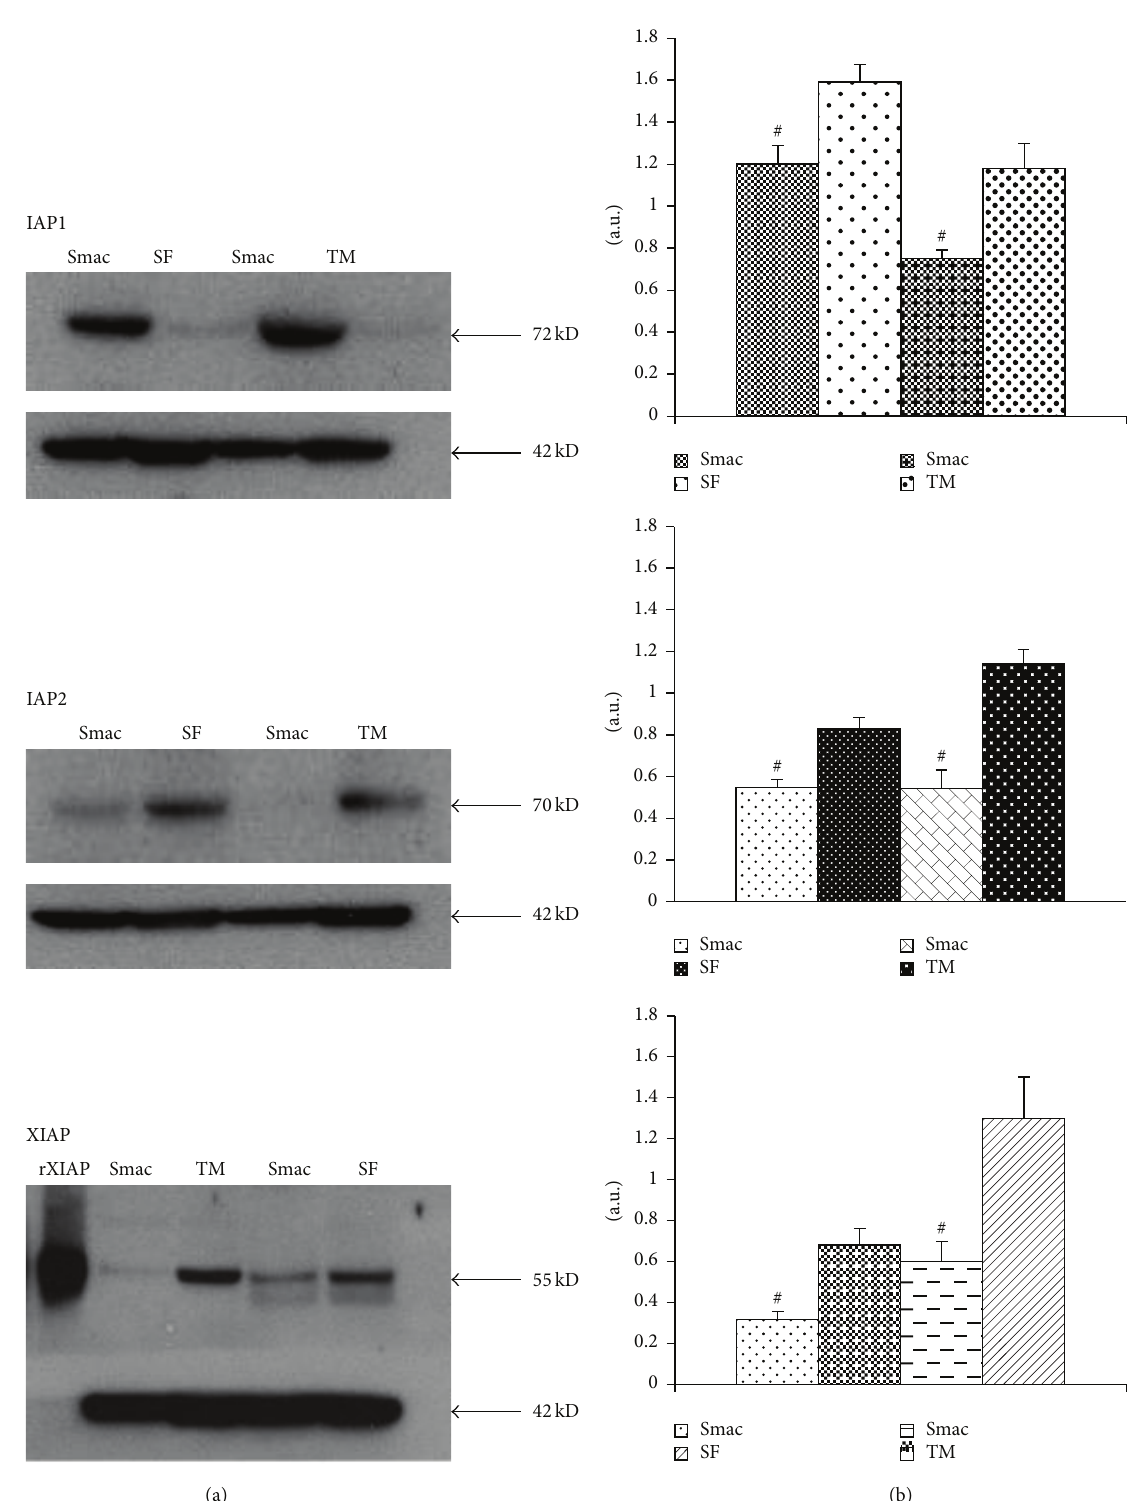
Figure 4: Smac127 inhibits the IAP proteins in RA-FLSs cultured in tissue medium or in synovial fluid. RA-FLSs were grown in tissue medium (TM) or in synovial fluid (SF). Smac127 (15 𝜇 M) was added for 48hrs. (a) Immunoblots show the detection of cIAP1 (72 kDa), cIAP2 (70 kDa), and XIAP (55kDa). 𝛽 -actin was used as a loading control (42kDa). (b) Densitometric analyses of the immunoblots show the ratio of IAPs/actin protein expression ± SD of the mean from four independent experiments. # 𝑝 < 0.05 indicates statistically significant differences compared to untreated